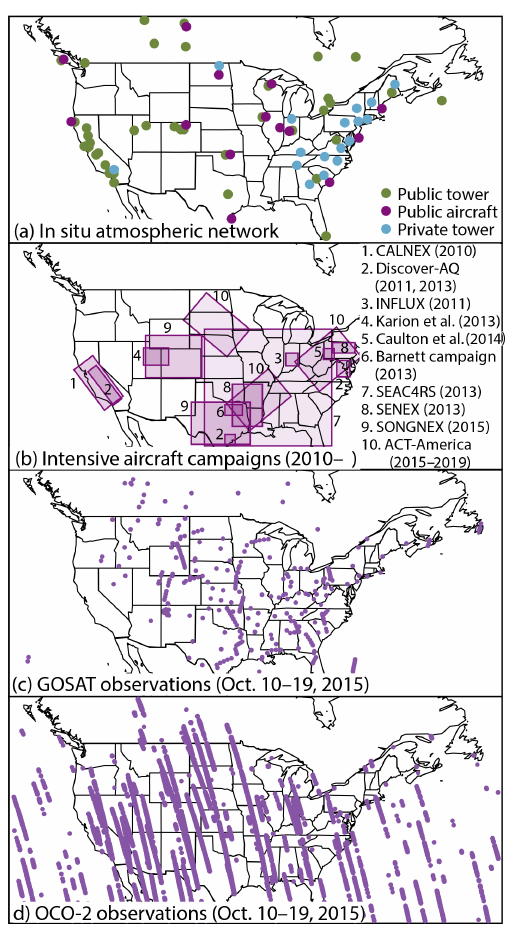
Figure 2. This figure highlights different CO 2 observation networks and how the spatial coverage of those networks differ. These net- works include tower and regular aircraft sampling sites (a) ; several recent, intensive aircraft campaigns (b) ; the GOSAT satellite (c) ; and the OCO-2 satellite (d) . Note that the dots in each panel are not equivalent. An in situ monitoring site in panel (a) often provides continuous or daily data, while each dot in panels (c) (GOSAT) and (d) (OCO-2) indicates the location of a single observation. Public towers and public aircraft sites are operated by NOAA, DOE, En- vironment Canada, and partners, and the sites shown are current through 2016. Private towers are operated by Earth Networks, and the locations here are current through 2012. Most tower and aircraft sites also include CH 4 observations, as does